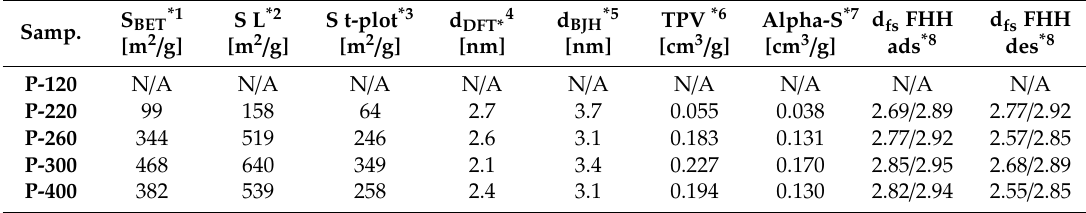
Table 1. Morpho-textural parameters of calcined